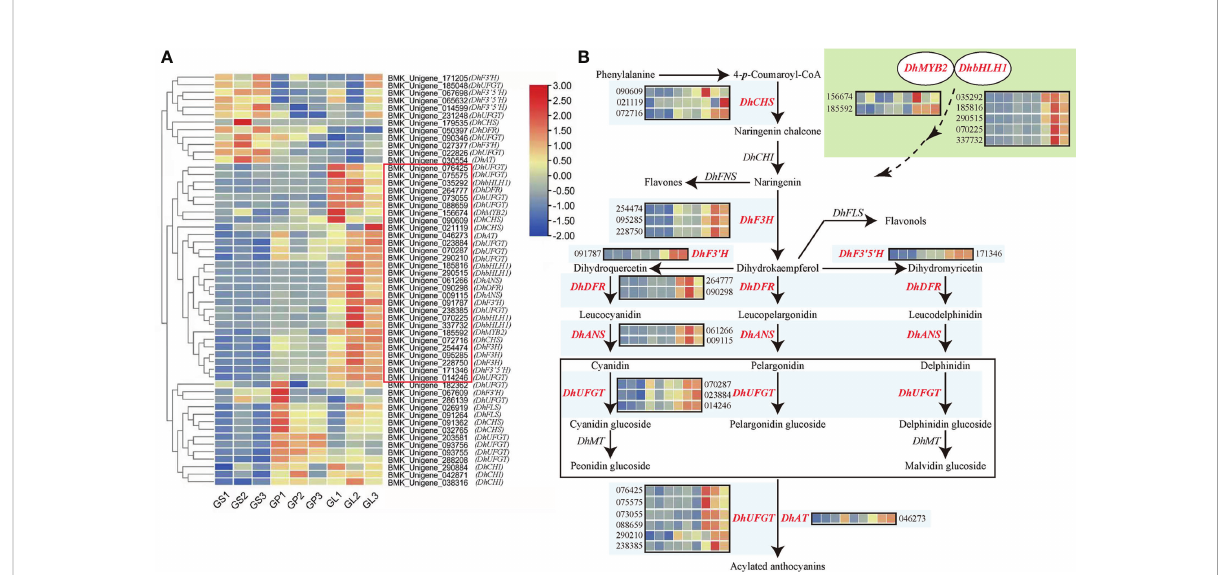
FIGURE 3 Clustered heatmap showing the expression patterns of transcription factor genes and fl avonoid biosynthesis related DEGs in different fl oral tissues of D. ‘ Suriya Gold ’ . (A) Cluster analysis of DhMYB2 and DhbHLH1 as well as differentially expressed genes involved in the fl avonoid and anthocyanin biosynthesis pathway. The log 2 ratio values of the expression in each comparison of DEGs were used for cluster analysis with the R heatmap package. The color changes from blue (low level) to red (high level) represent the log2FPKM values measured from different fl oral tissues of D. ‘ Suriya Gold ’ . The red rectangle highlights the unigenes with similar expression pro fi les as DhMYB2 and DhbHLH1 . GS 1-3 , GP 1-3 and GL 1-3 represent sepals, petals, and lips of D. ‘ Suriya Gold ’ from three biological replicates, respectively. (B) Schematic diagram of ABP in Phalaenopsis -type Dendrobium , illustrating the eight highlighted genes with similar expression pro fi les as DhMYB2 and DhbHLH1 .